Question: Briefly state, in one sentence, what is plotted here.
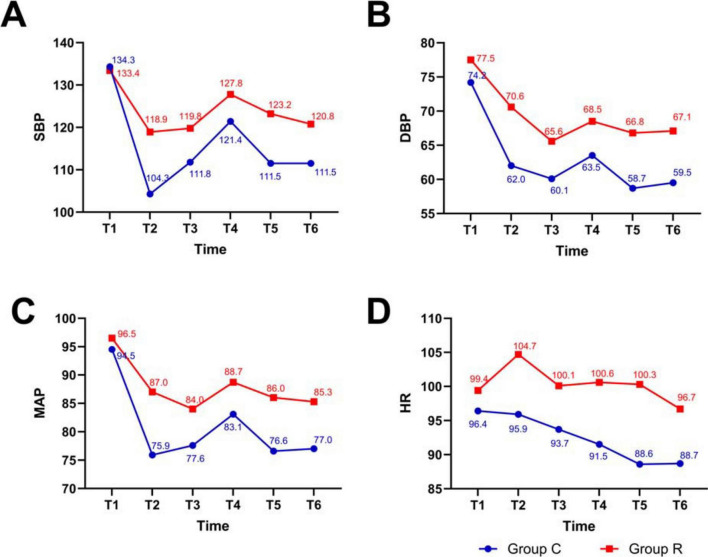
Answer: Intraoperative hemodynamic changes according to anesthetic group. Group C, propofol induction with volatile anesthetic maintenance; Group R, remimazolam-based total intravenous anesthesia. Mixed-effects model analysis demonstrated significant group-by-time interactions for systolic blood pressure (SBP, A , P = 0.024) and mean arterial pressure (MAP, C , P = 0.049), indicating different temporal patterns between groups, with higher SBP and MAP maintained in the remimazolam group. Diastolic blood pressure (DBP, B ) showed significant main effects of time ( P < 0.001) and group ( P < 0.001) but no significant group-by-time interaction ( P = 0.181). Heart rate (HR, D ) demonstrated significant effects of time ( P < 0.001) and group ( P = 0.002), with a significant group-by-time interaction ( P < 0.001).